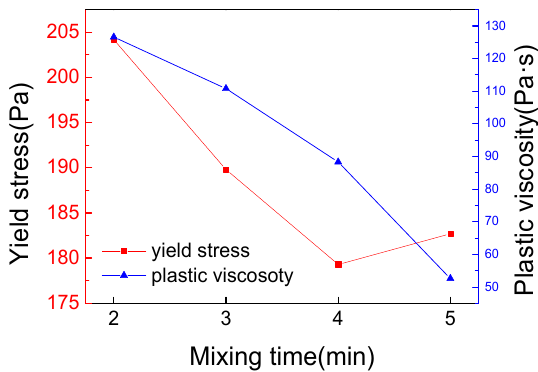
Figure 6. E ff ect of mixing time on the rheological parameters of SCC. Figure 6. Effect of mixing time on the rheological parameters of SCC.